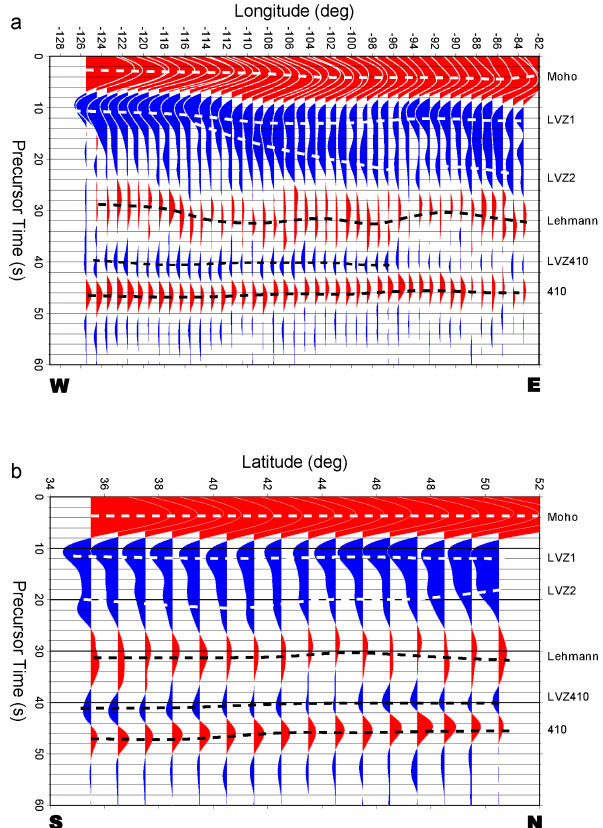
Figure 4. Display of binned S-receiver function traces along a (a) west–east and (b) south–north line. LVZ1 is the LAB in the western United States and the MLD in the central US. Details of LVZ1 and LVZ2 are shown in the narrower profiles in Figs. 8 and 9. “Lehmann” indicates the bottom of the asthenosphere, and LVZ410 marks a velocity drop above the 410km discontinuity. Note that this discontinuity is only weakly observed at the eastern end of the line. “410” is the discontinuity at 410km depth. Although these disconti- nuities are greatly averaged in this display, they appear very